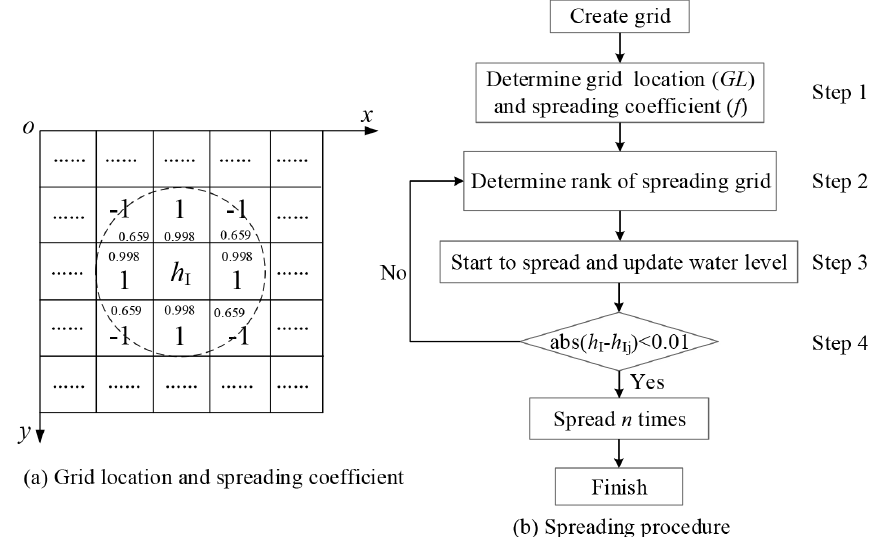
Figure 3. Description of the spreading process: (a) determination of the grid location and spreading coefficient and (b) iterative calculation of the spreading process.